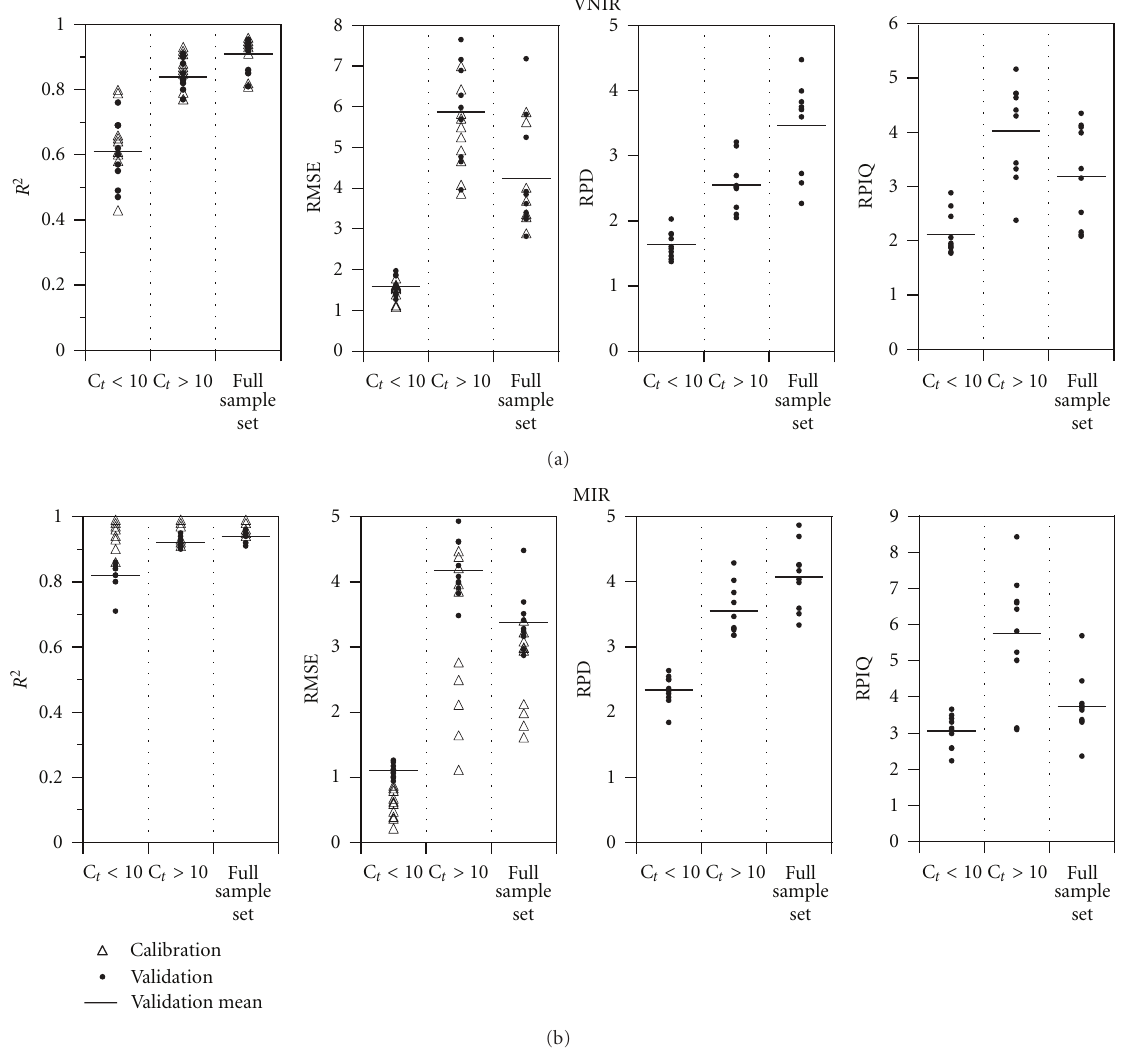
Figure 3: Visual assessment of partial least squares regression model results for soil total carbon (C t ) prediction from subsets of (a) visible/near-infrared (VNIR) and (b) mid-infrared (MIR) di ff use reflectance spectra based on C t content. The parameters given are the coe ffi cient of determination ( R 2 ), root mean squared error (RMSE, %), residual prediction deviation (RPD), and the ratio of performance to interquartile distance (RPIQ). The range of values reflects the results of 10 random iterations of the models. Results are also shown for full sample set models with no subsetting for